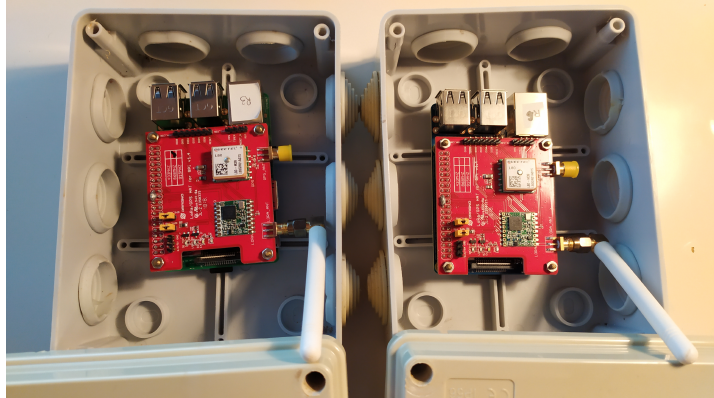
Figure 1. Nodes used during the experimentation